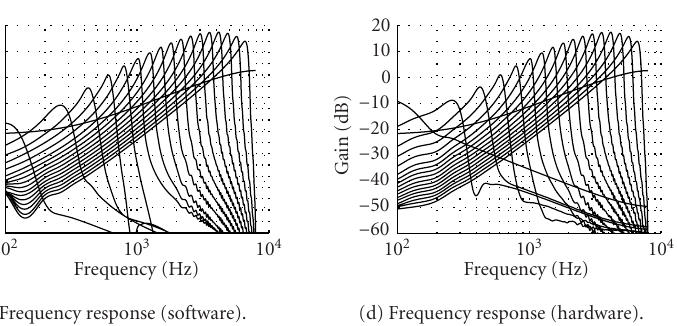
Figure 6: Impulse response of (a) the software floating-point implementation and (b) hardware 16-bit wordlength, 16-bit ROM width implementation. Frequency response of (c) the software floating-point implementation and (d) hardware 16-bit wordlength, 16-bit ROM width implementation.